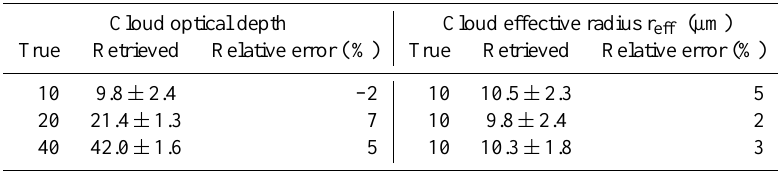
Table 2. Statistics of true and retrieved cloud optical depth and effective radius for 1-D plane-parallel clouds. The solar zenith angle was 45 ◦ ; the surface albedo values at 440, 870 and 1640nm were respectively 0.05, 0.3 and 0.25.